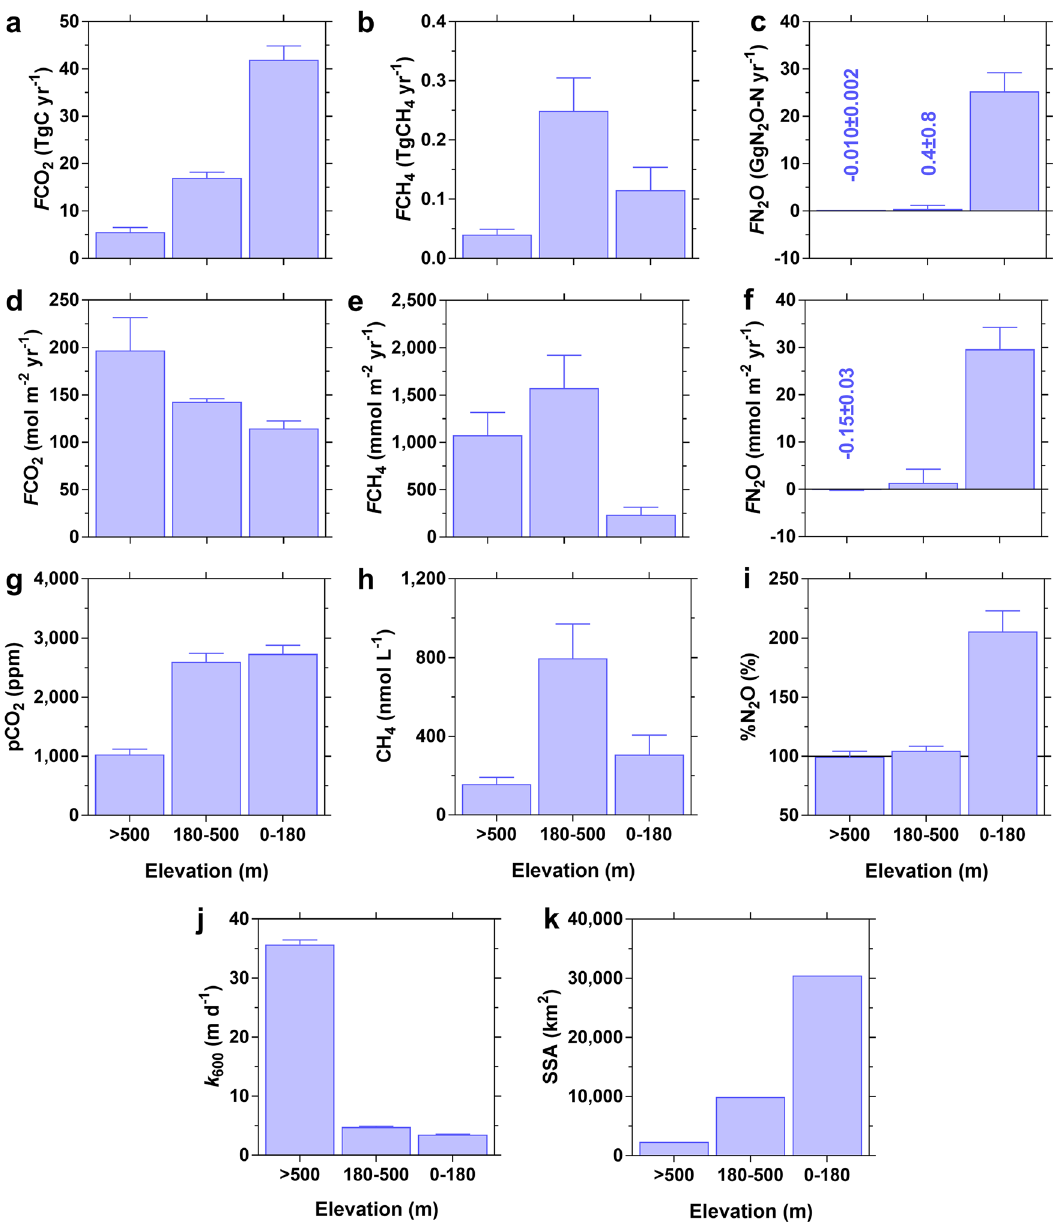
(elevation 180 – 500 m) and lowland (elevation <180m) streams and rivers of the whole Amazon basin. Fluxes were computed from concentrations and k 600 modelled from attributes of RiverATLAS 68 for 744,786 river segments. Error bars indicate uncertainties derived from error